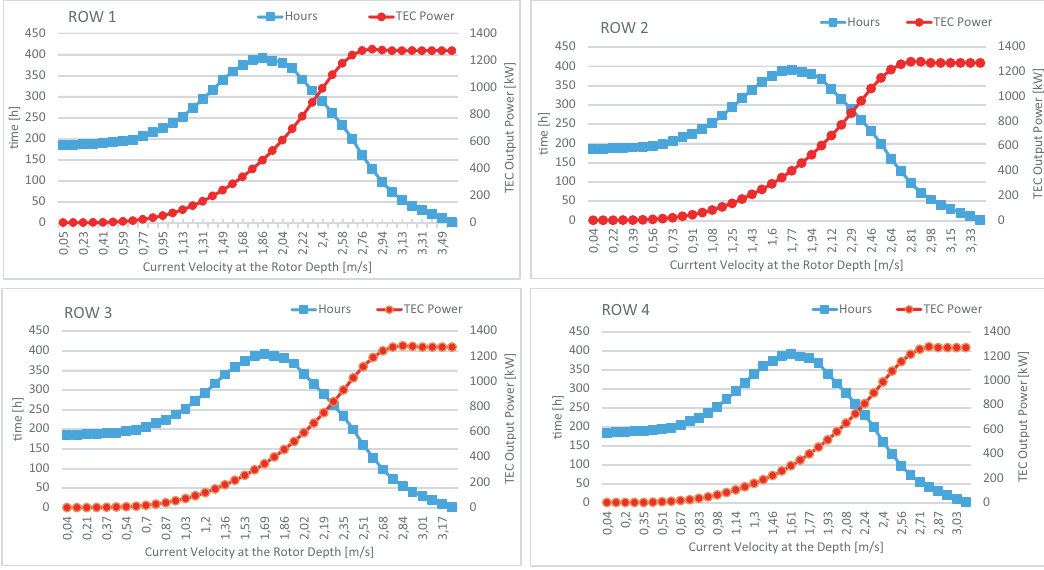
Figure 9. Energy generation of a TEC placed in the different rows of the tidal farm.